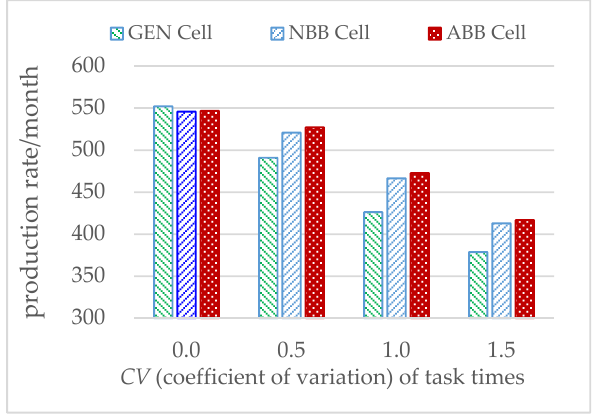
Figure 7. Performance of assembly systems with various assembly time variabilities.